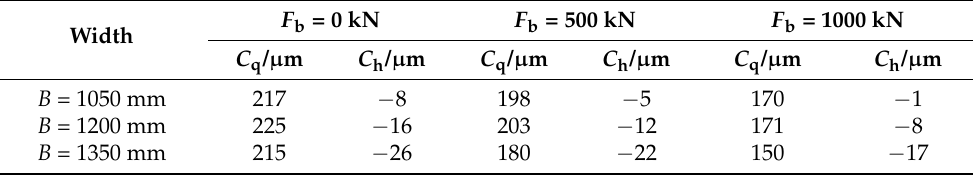
Table 6. Simulation condition of the influence of bending force on strip crown. Figure 7. Influence of bending force on strip crown. ( a ) B = 1050 mm; ( b ) B = 1200 mm; ( c ) B = 1350 mm. Table 7. Results of analyzing the influence of bending force on strip crown.